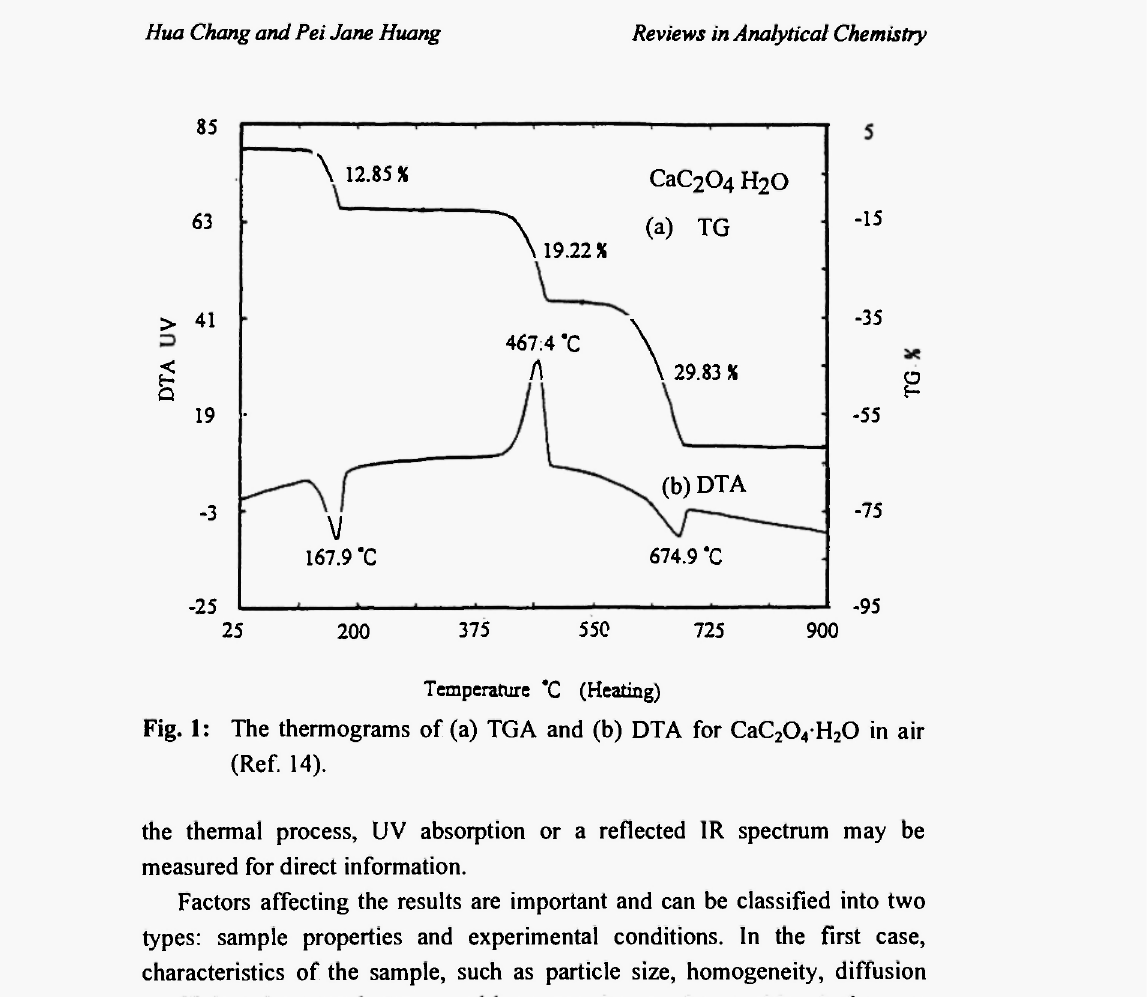
Fig. 1: The thermograms of (a) TGA and (b) DTA for CaC 2 0 4 H 2 0 in air (Ref.